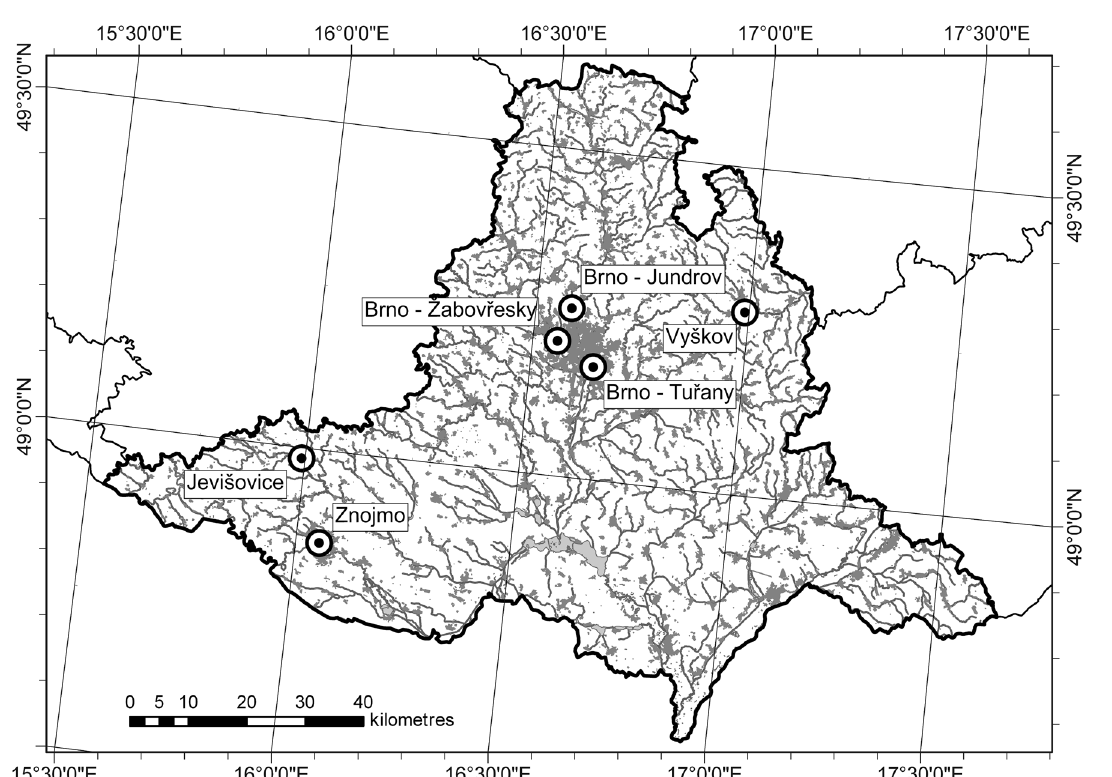
Fig. 1. Rain gauge stations within the South Moravian Region, Czech